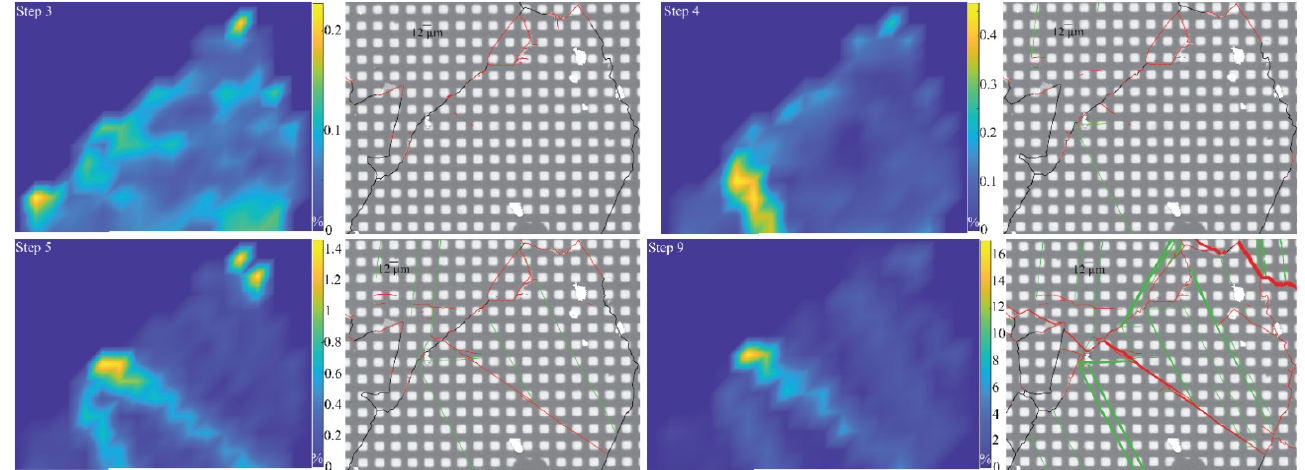
Figure 25. Equivalent Von Mises deformation map of crystal 20 at different steps of sample defor- mation. The black lines represent the grain boundaries. The green lines show the twinned planes. The red lines show the fracture zones.